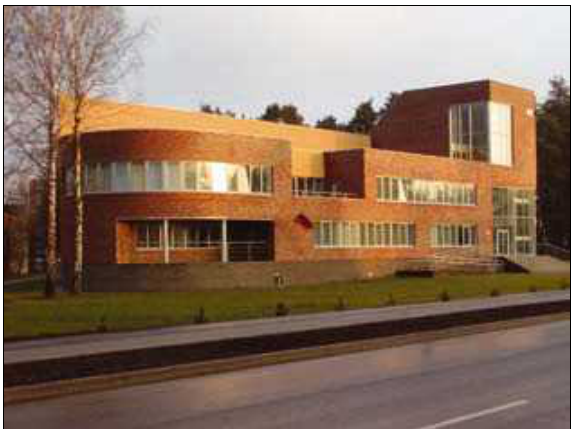
Fig. 8. s­tate office bu­ilding in